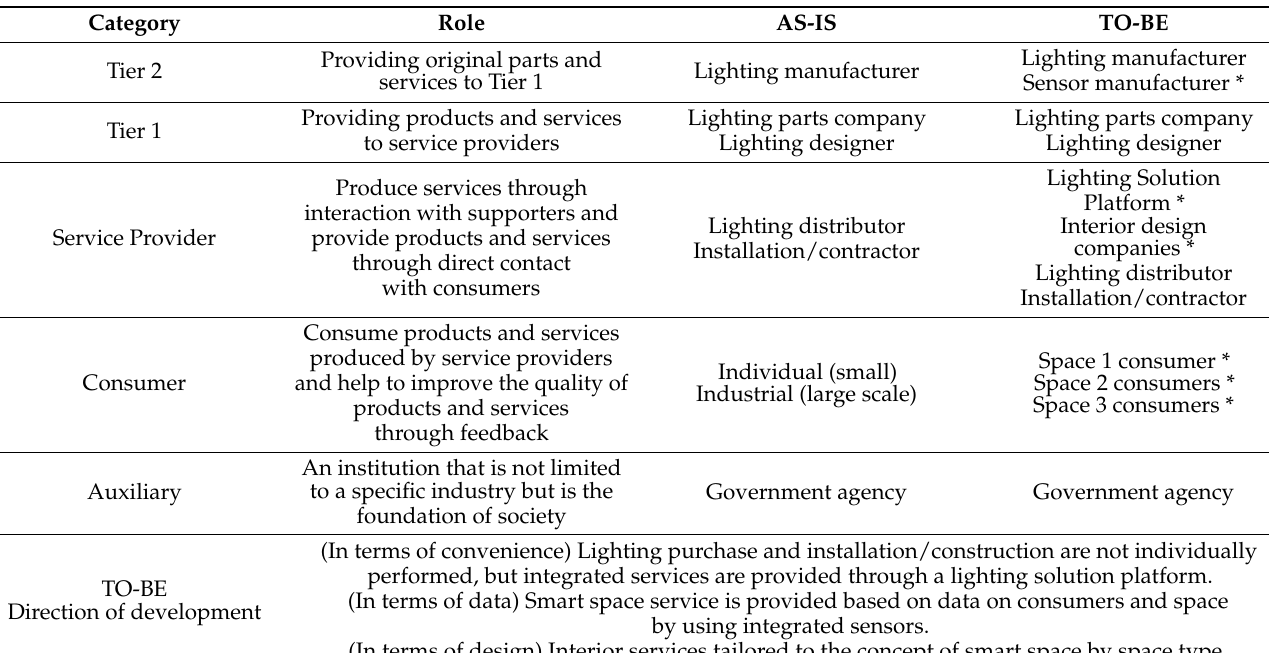
Table 2. HCL Eco-system Stakeholders.